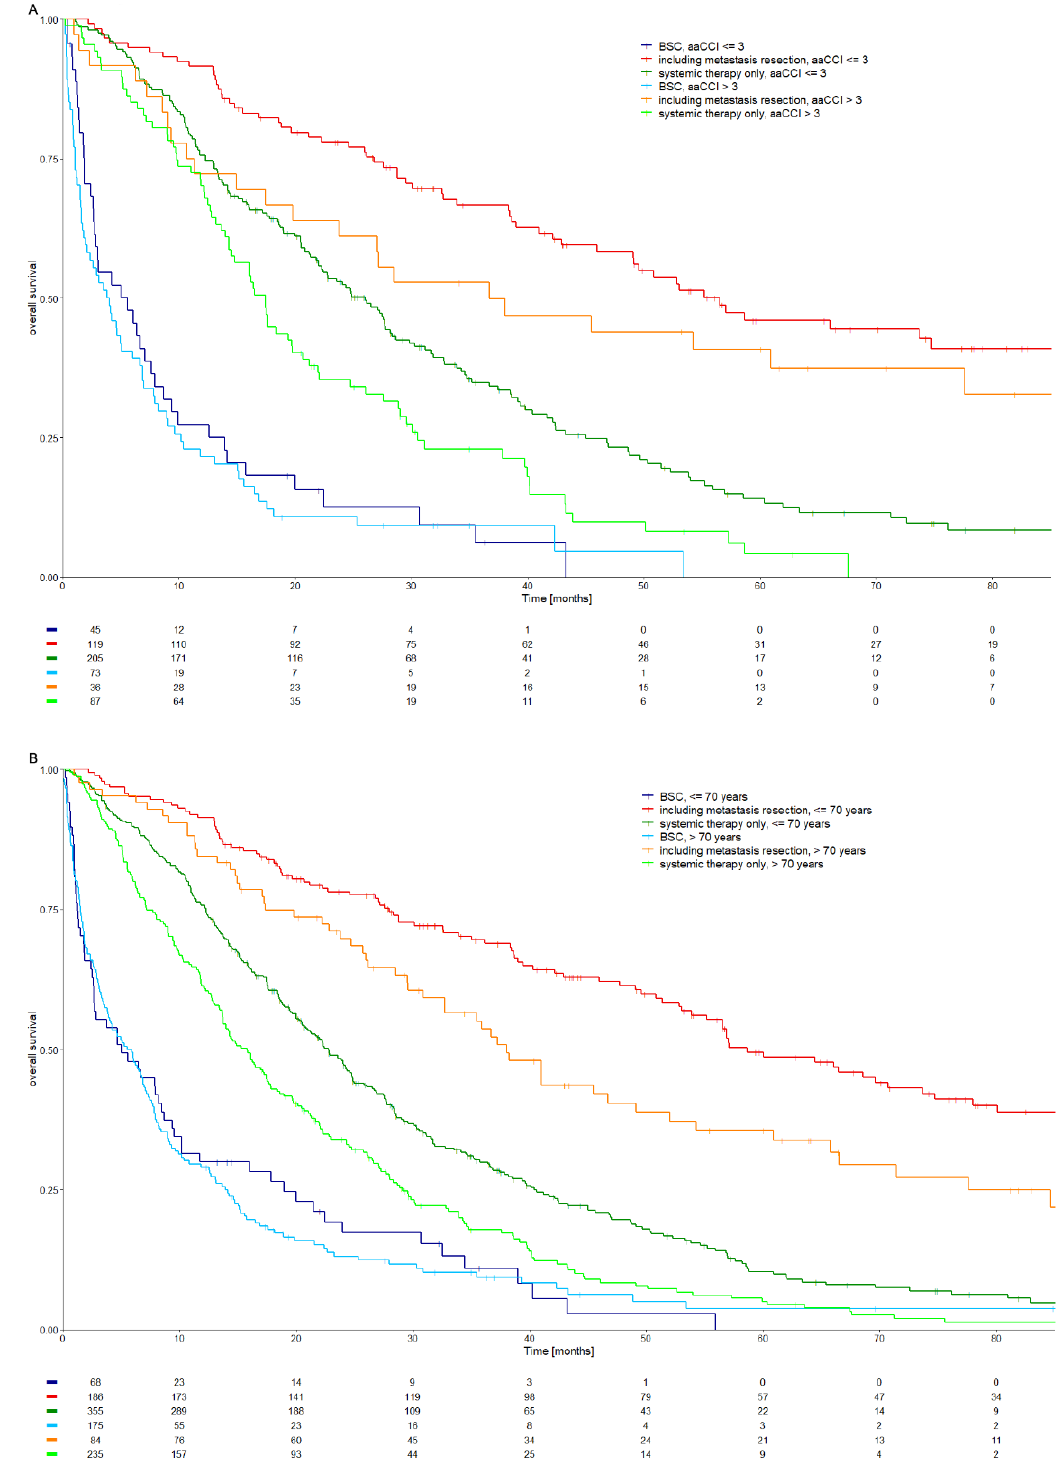
Figure 2. Overall survival by treatment type and age-adjusted Charlson Comorbidity Index ( A ) or age ( B